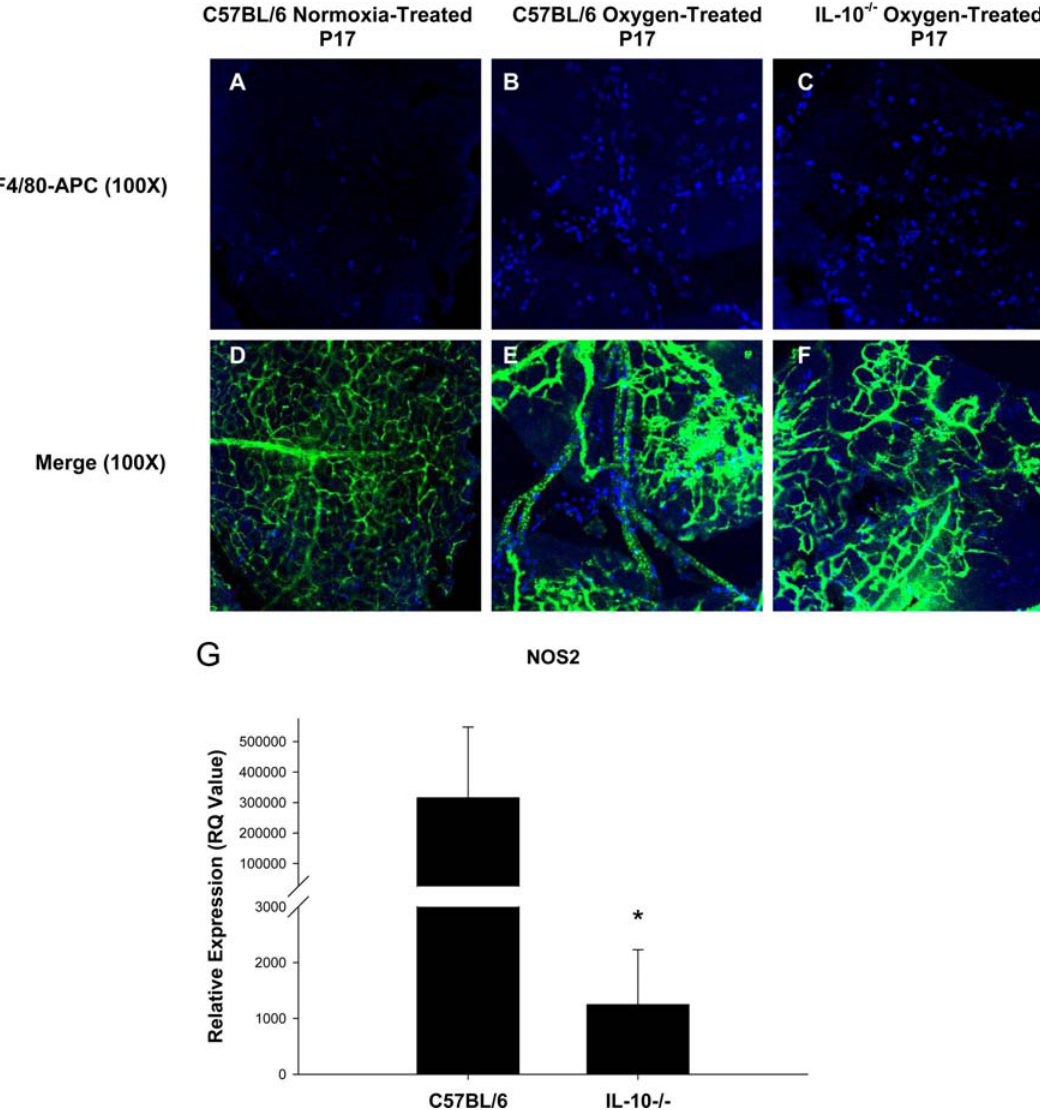
Figure 3. F4/80 + macrophages infiltrate ischemic retinas of both C57BL/6 and IL-10 2 / 2 mice. Retinal flatmounts of P17, FITC-dextran perfused C57BL/6 normoxia-treated, C57BL/6 oxygen-treated, and IL-10 2 / 2 oxygen-treated retinas were stained with Allophycocyanin (APC) anti- mouse F4/80 antibody. In contrast to the paucity of cells in the (A) normoxic wild-type retina, a significant number of F4/80 + macrophages are observed in the retinas of both (B) C57BL/6 oxygen-treated and (C) IL-10 2 / 2 oxygen-treated mice. (D, E, F) Examining both macrophage infiltrate and blood vessels reveals that APC-labeled macrophages reside primarily along FITC-dextran perfused blood vessels. Since IL-10 did not prevent macrophage infiltration into the retina, we examined the genetic profile of retinal macrophages. Using splenic wild-type macrophages as a baseline, retinal macrophages from wild-type mice exhibit significantly (p , 0.05) increased expression of the pro-angiogenic gene (G) nitric oxide compared to IL-10 2 / 2 retinal macrophages following OIR, suggesting that IL-10 promotes angiogenesis by polarizing macrophages towards a pro-angiogenic phenotype.